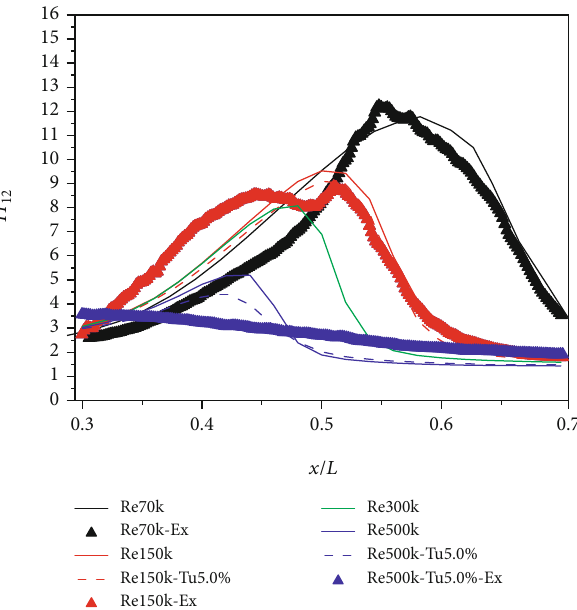
Figure 14: Shape factor comparison ( Tu = 1 : 5 %).